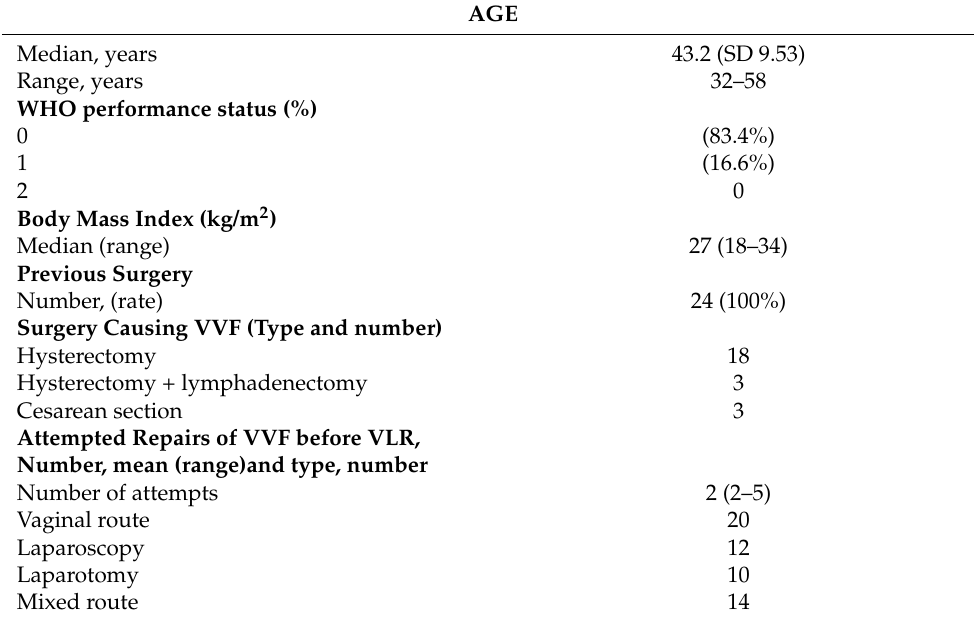
Table 1. Patient’s characteristics ( n = 24) and previous